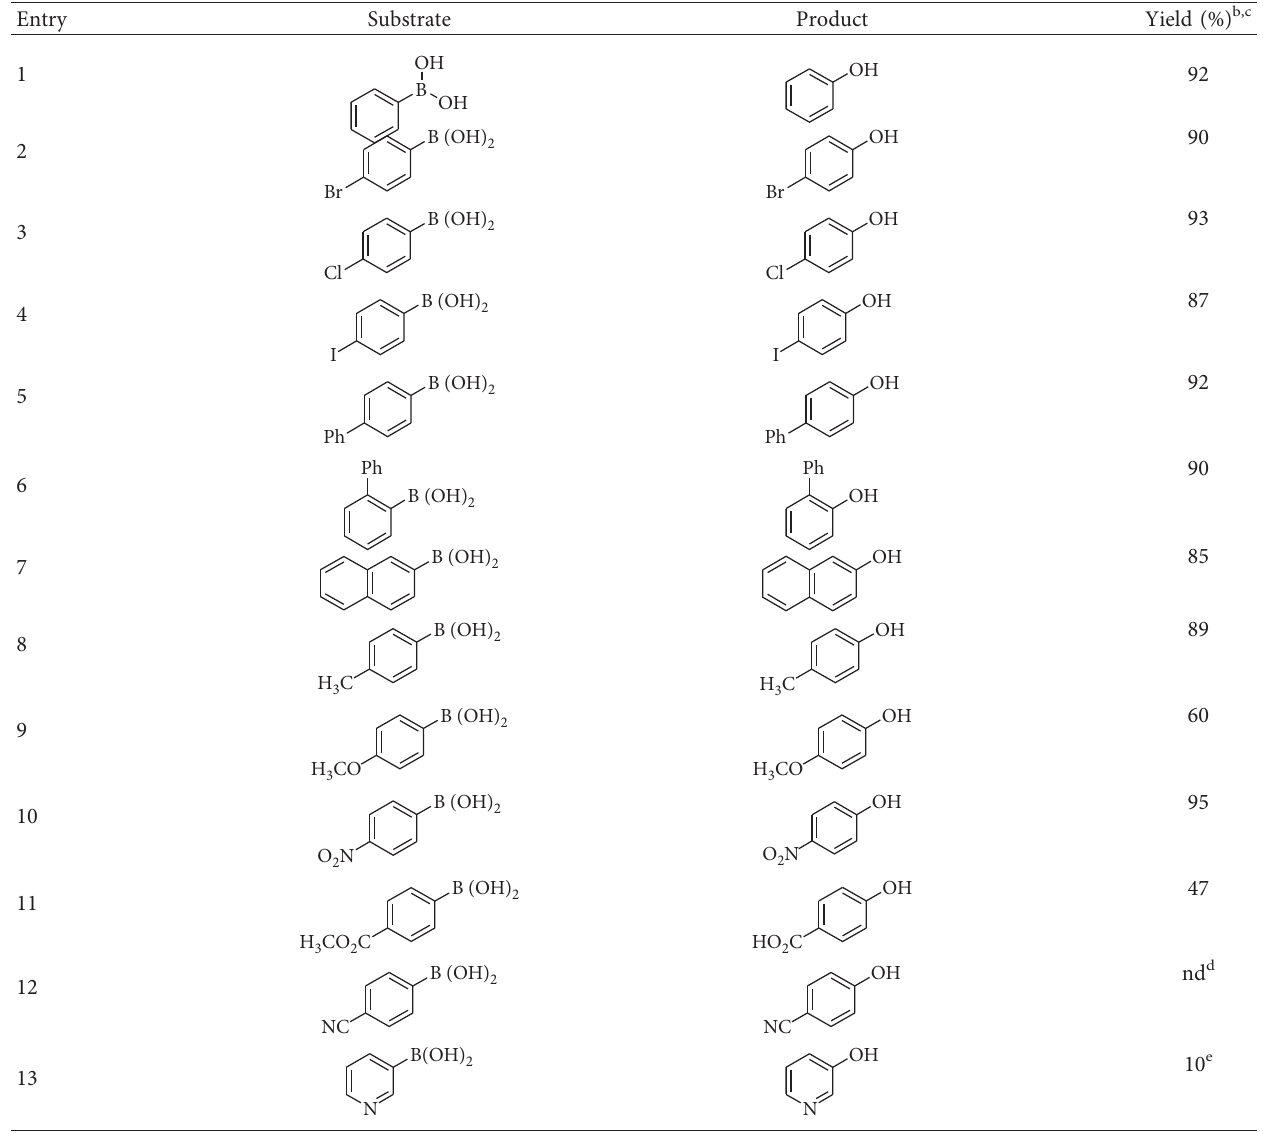
Table 3: Substrate scope for the direct hydroxylation of aryl boronic acids a